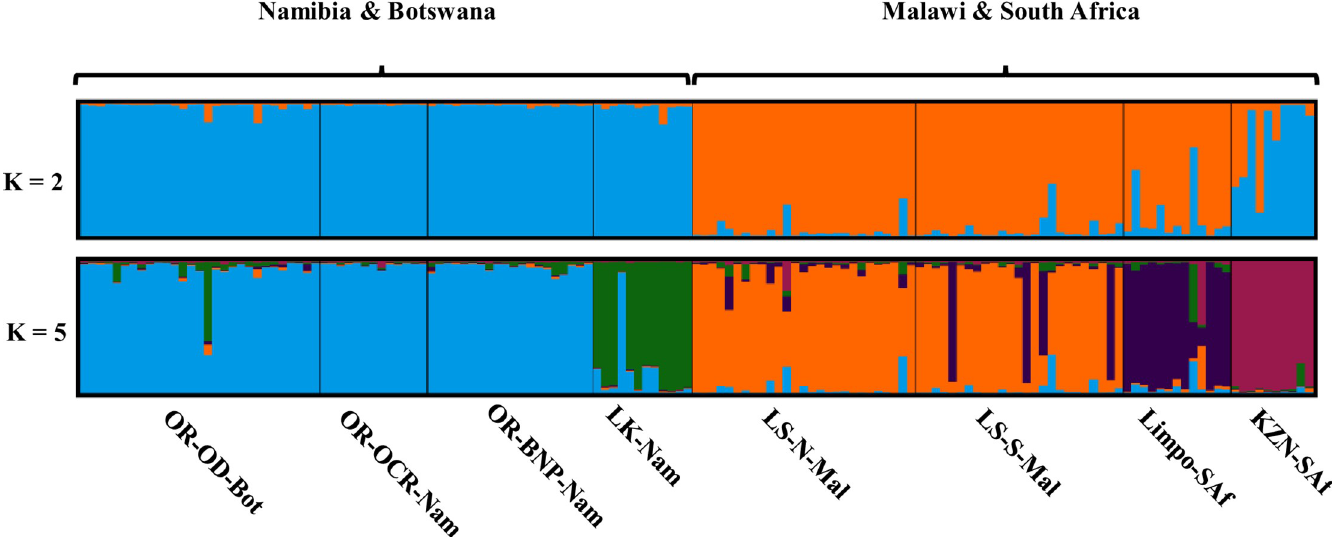
Fig 2. STRUCTURE bar plot showing the distribution of Nile crocodile populations. The most likely number of population clusters, K = 2 (based on Δ K , representing the upper hierarchical level) and K = 5 (based on all other estimates, giving a more “localised” regional evaluation of population structure).